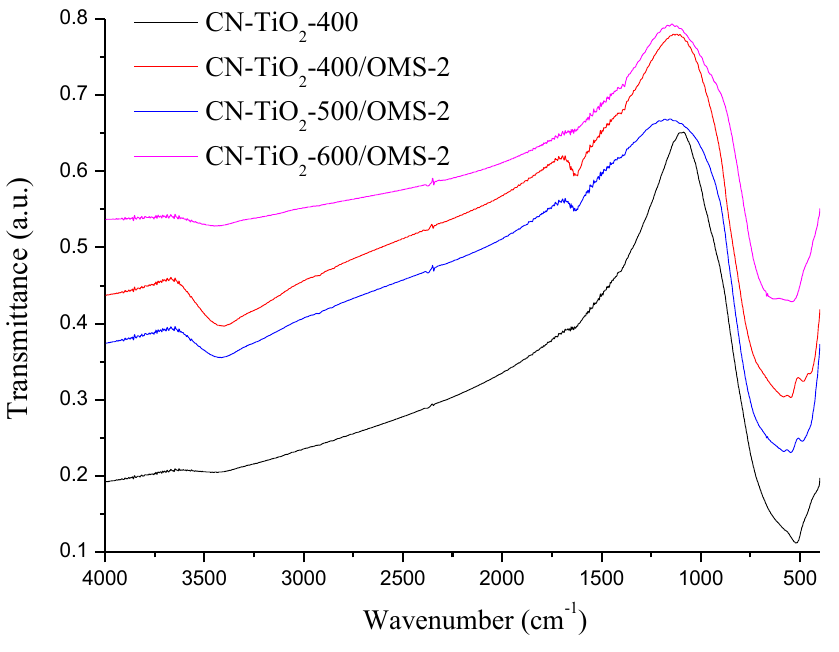
Figure 3. FT-IR spectra of CN-TiO 2 /OMS-2 samples and reference.